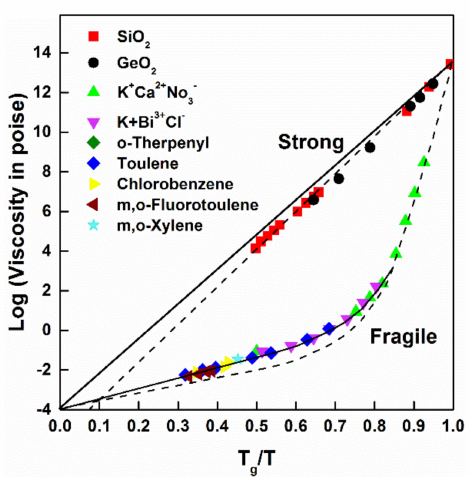
Figure 2. Comparison of η ( T ) for “strong” and “fragile” glass-forming liquids. Adopted from [37], with permission from Elsevier, 1988.